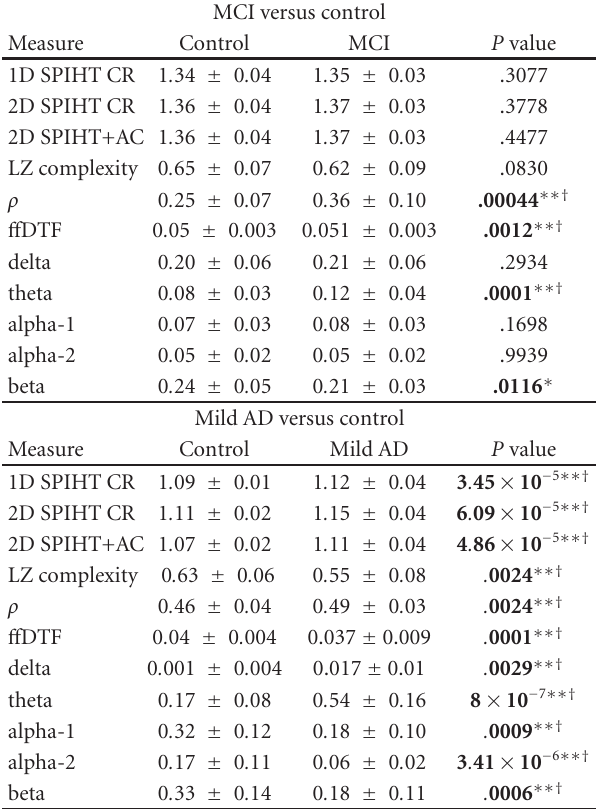
Table 2: Mean and standard deviation values of compression ratio, LZ complexity, relative power, and synchrony measures. Sensitivity of the measures in discriminating between MCI and mild AD is given in last column. Uncorrected P values from Mann-Whitney test, where ∗ and ∗∗ indicate P < . 05 and P < . 005, respectively; † Indicates P values that remain significant after postcorrection (Bonferroni, P < .